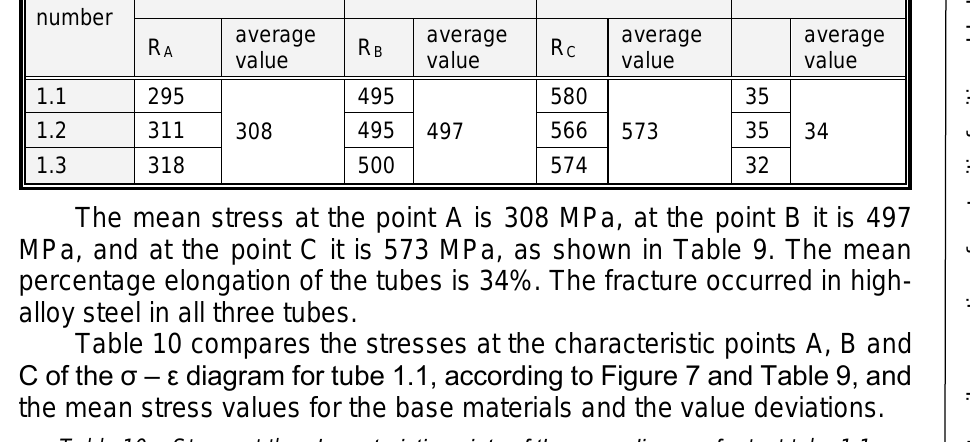
Table 10 – Stress at the characteristic points of the σ – ε diagram for test tube